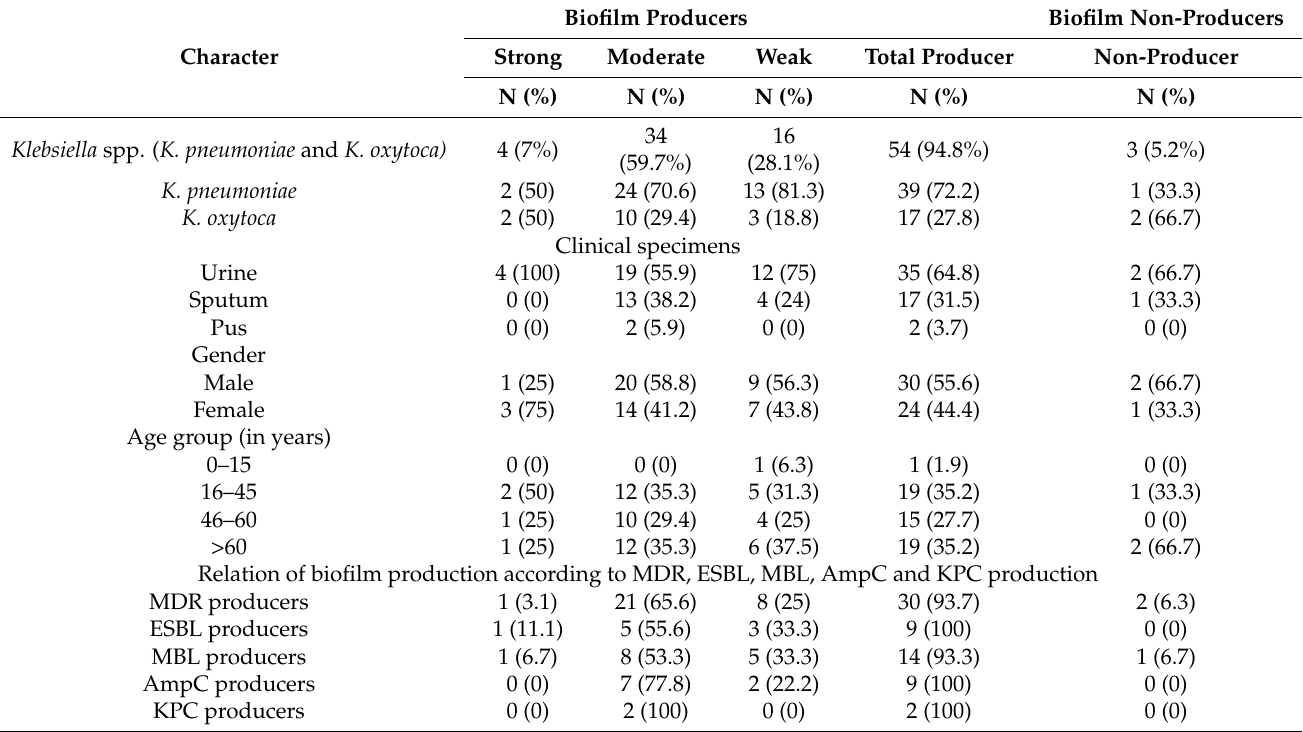
Table 5. Biofilm production among Klebsiella pneumoniae and K. oxytoca isolates in relation to species, clinical specimens, gender and age.